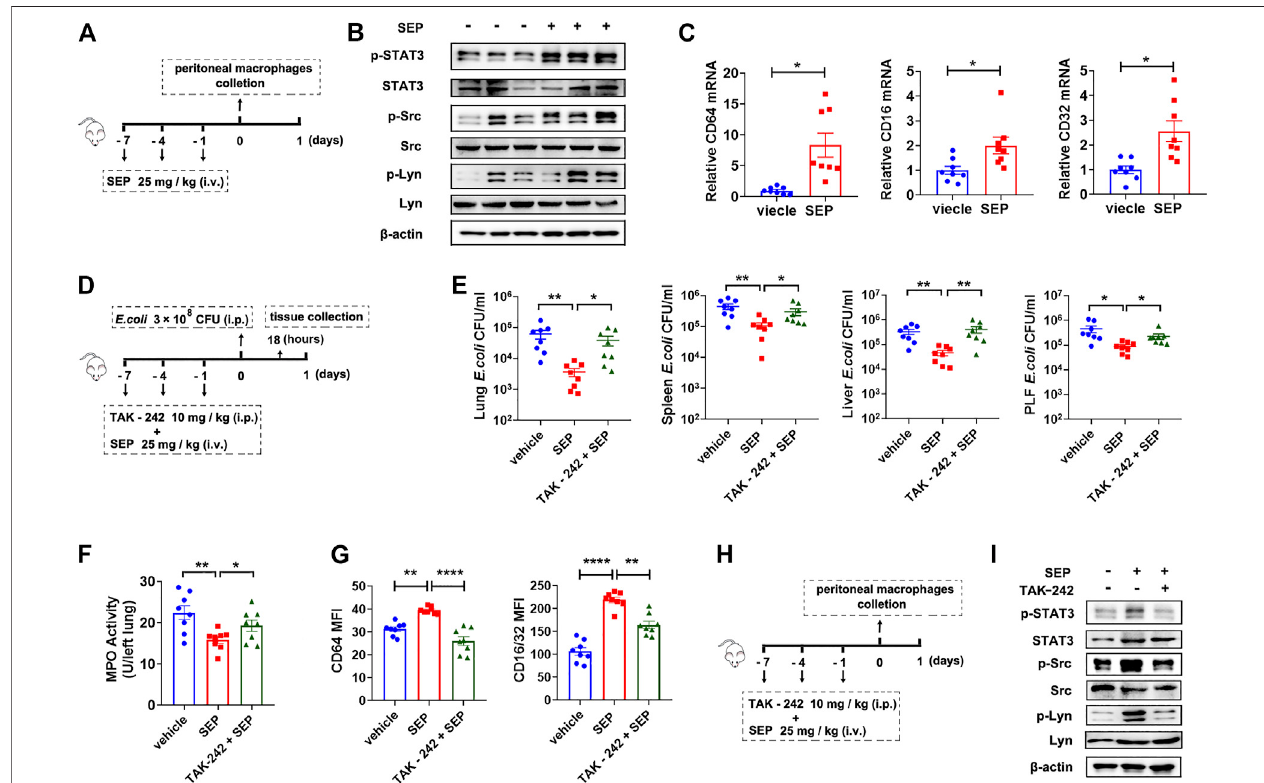
FIGURE6| InhibitionofTLR4abolishestheprotectionofSEPagainst E.coli infection. (A) TheexperimentaldesignofSEPadministrationinmice.Miceweretreated with SEP (25 mg/kg) or vehicle (saline) by i. v. every 3 days for three times, and sacri fi ced on the eighth day. The total protein and mRNA were extracted from mice peritoneal macrophages. (B) The protein levels of p-STAT3, p-Src and p-Lyn in the peritoneal macrophages were determined by western blot. (C) The relative mRNA levels of CD64, CD32 and CD16 in the peritoneal macrophages were determined by q-PCR. (D) The experimental design of TAK-242 combined with SEP administrationinmiceinfectionmodel.TheTAK-242groupmicewerepre-treatedwithTAK-242(10 mg/kg,i.p.)2 hbeforeadministrationofSEP,onceevery3 daysfor three times.Thenmice werefurtherchallenged with E.coli (3×10 8 CFU,i.p)ondayeightand sacri fi cedat18 hpost-infection.( n =8). (E) CFUof E.coli wasdetected in tissue homogenates of lung, spleen, liver, and peritoneal lavage fl uid. (F) MPO value in the lung tissue. (G) The protein levels of CD64 and CD16/32 in the peritoneal macrophages were determined by fl ow cytometry. (H) The experimental design of TAK-242 combined with SEP administration in mice. The TAK-242 group mice were pre-treated with TAK-242 (10 mg/kg, i. p.) 2 h before administration of SEP, once every 3 days for three times, and sacri fi ced on the eighth day. (I) The protein levels of p-STAT3, p-Src and p-Lyn in the peritoneal macrophages were determined by western blot. All data are represented as mean ± SEM acquired in triplicate determinations. * p < 0.05, ** p < 0.01, **** p <